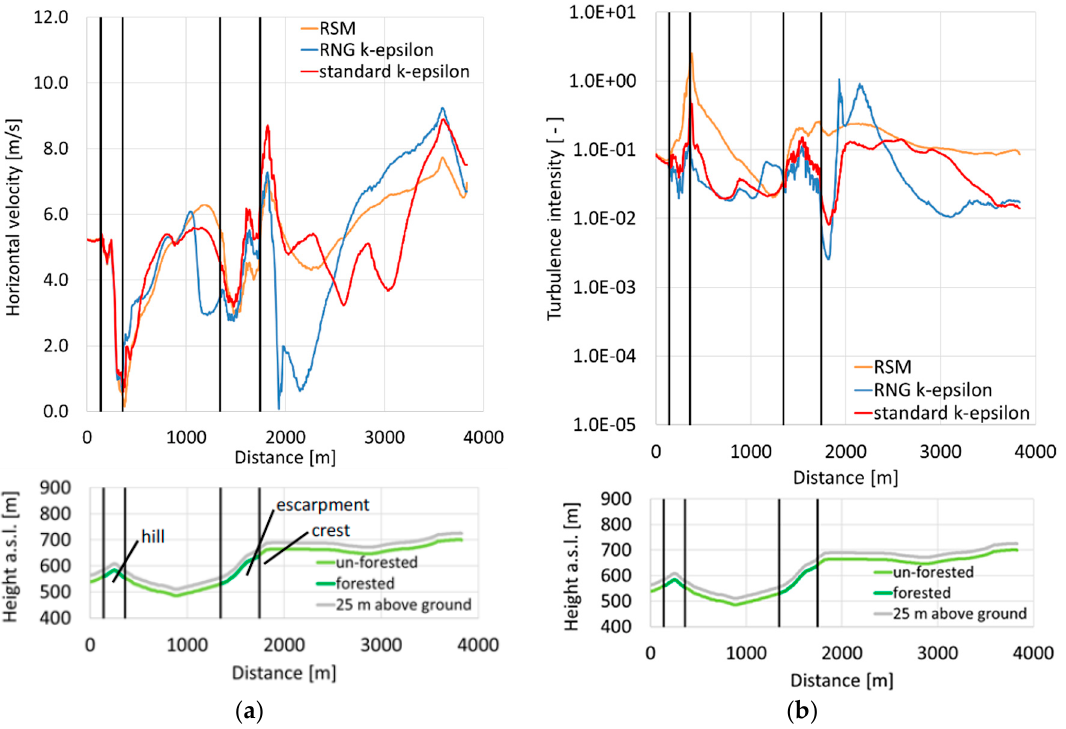
Figure 6. ( a ) Horizontal velocity at a constant distance of 25 m above the ground (grey line); ( b ) turbulence intensity at a constant distance of 25 m above the ground (grey line).